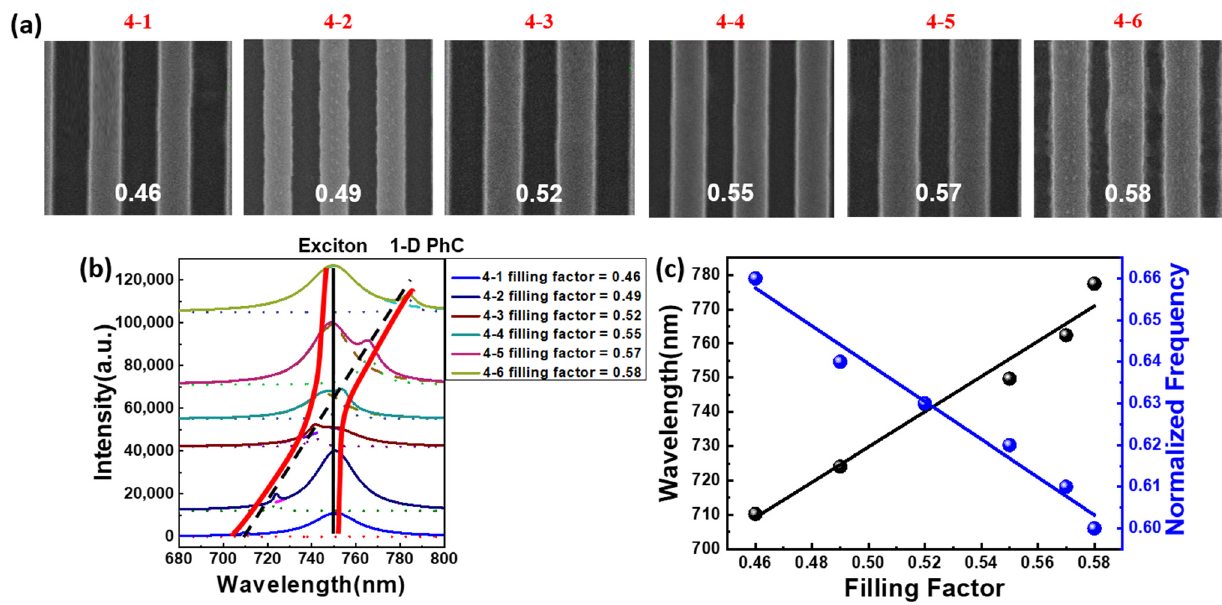
Figure 5. ( a ) Different 1-D PhCs (4–1 to 4–6) with various filling factors. ( b ) Spectrum of the coupled system for different filling factor ratio in the same period of 470 nm. ( c ) Coupling wavelength and corresponding normalized frequency for different filling factors.